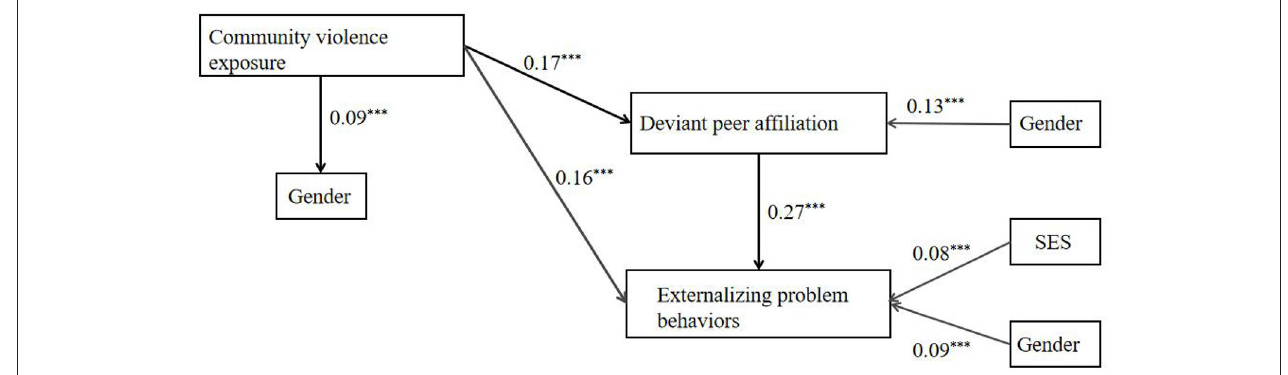
FIGURE 2 | Model of the mediating role of deviant peer affiliation between community violence exposure and externalizing problem behaviors. *** p < 0.001.